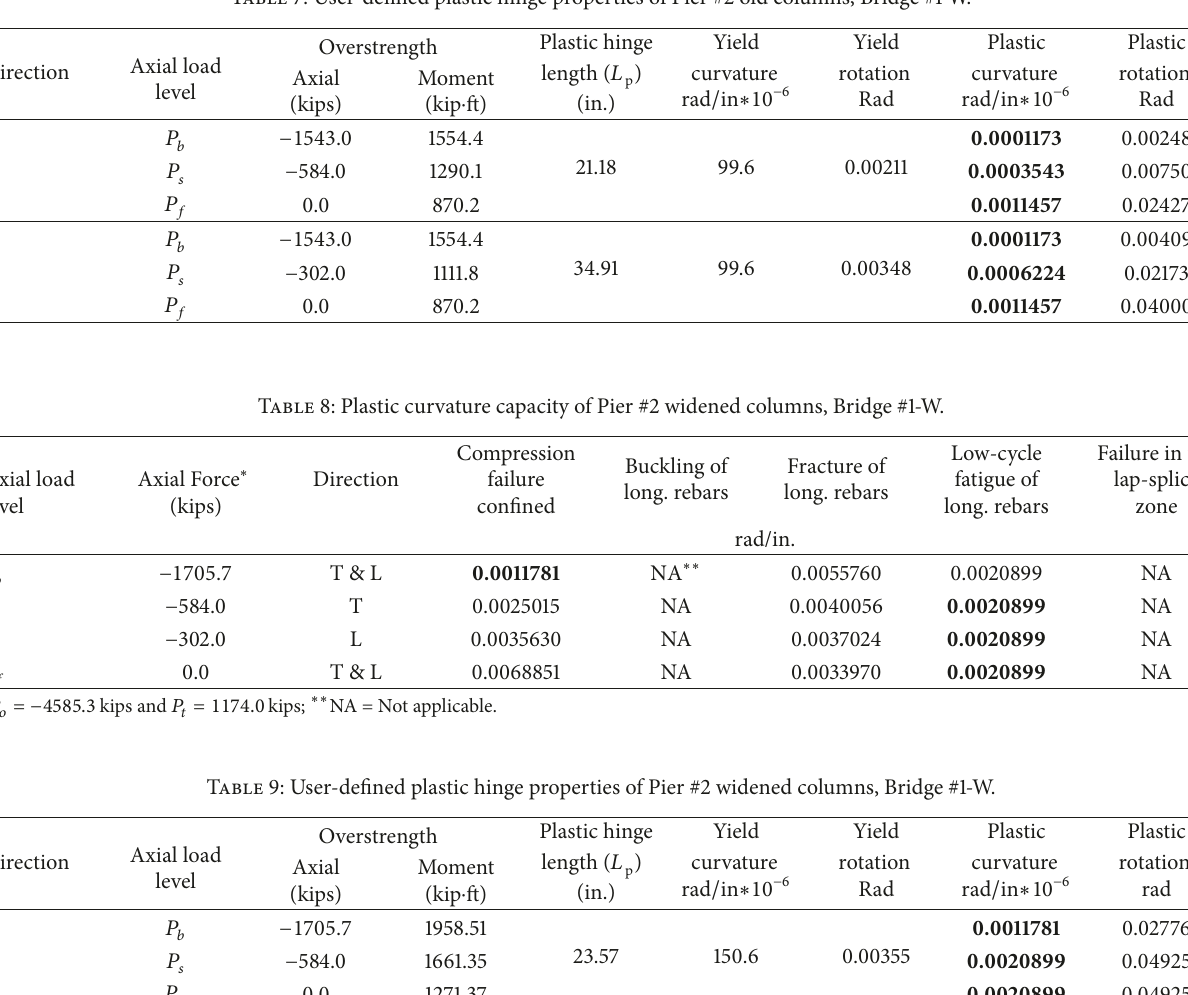
Table 7: User-defined plastic hinge properties of Pier #2 old columns, Bridge #1-W.